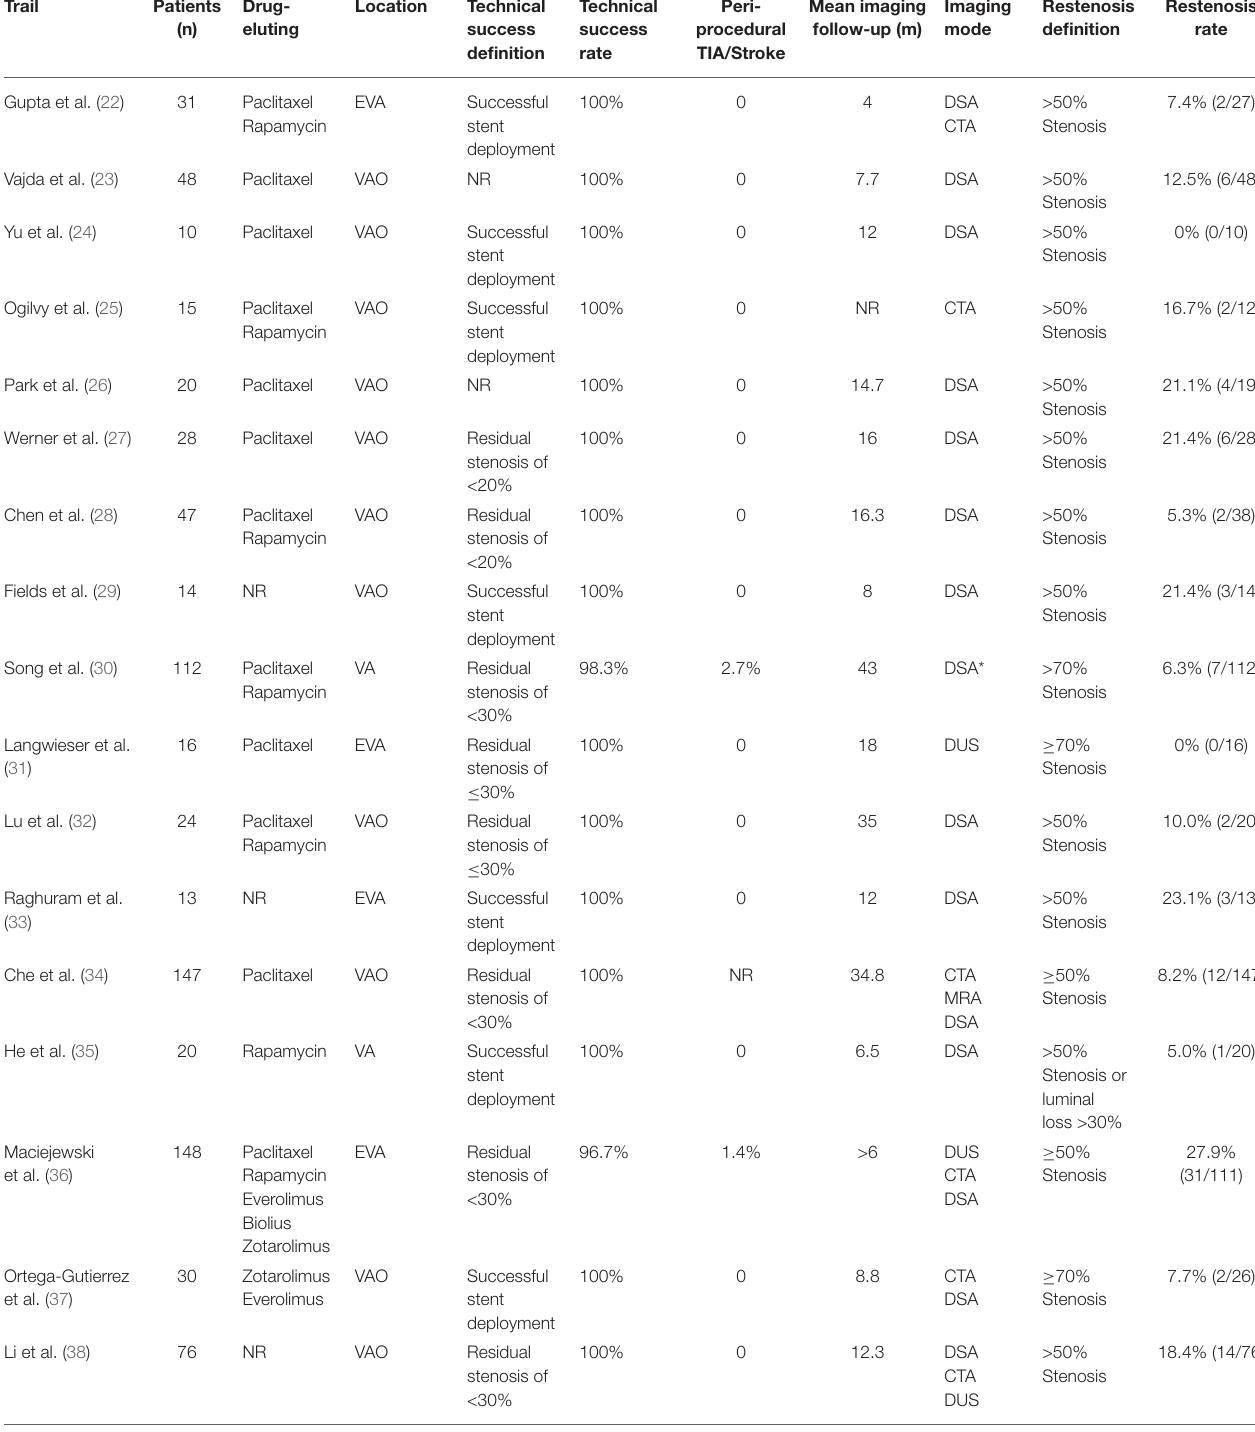
TABLE 3 | Summary of reports of vertebral artery angioplasty and stenting with drug-eluting stents.